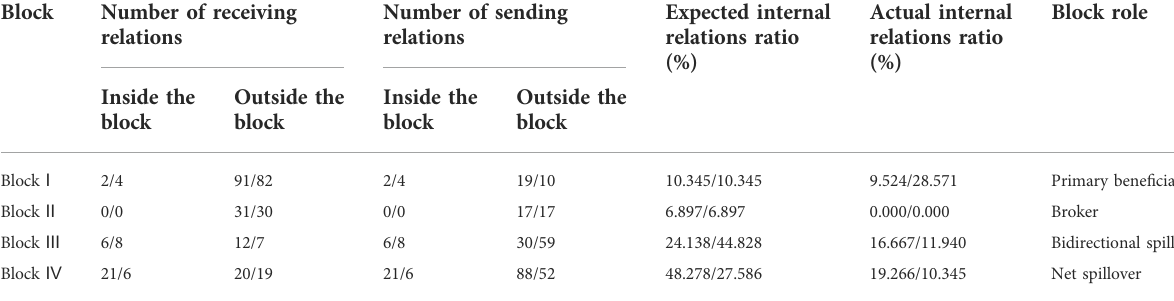
TABLE 6 The spillover effect of four blocks of spatial association network of GIE in China.